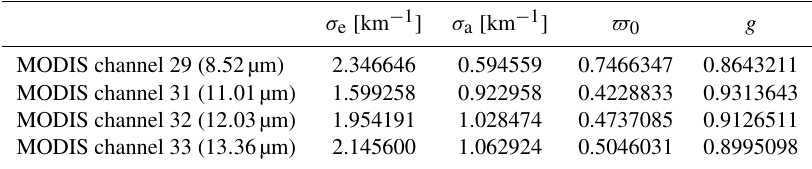
Table 2. Bulk scattering properties (extinction coefficient σ e , absorption coefficient σ a , single-scattering albedo (cid:36) 0 and asymmetry parameter g ) of the aggregate column ice crystal (Yang et al., 2013) with an effective diameter of 20µm for the four channels used in this study. σ e [km − 1 ] σ a [km − 1 ] (cid:36) 0